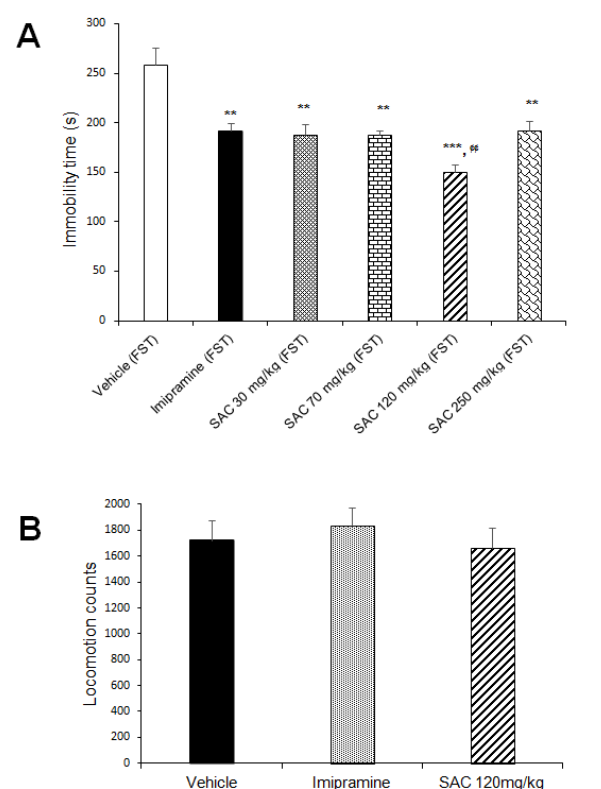
Figure 2. SAC produced an antidepressant-like response in the FST ( A ) and did not alter locomotor activity ( B ). Before FST, vehicle, imipramine (15 mg / kg), or SAC (30, 70, 120, or 250 mg / kg) were administered to mice daily for 17 days. Immobility time (in seconds) and locomotion scores are expressed as mean ± SEM, with 9–15 mice per group for antidepressant-like response and 11–15 mice per group for locomotor activity. The one-way ANOVA followed by post hoc Duncan’s test was used to analyze di ff erences among groups. (**) Statistically di ff erent from the vehicle-FST group (control group, p < 0.01, Duncan´s test; (***) Statistically di ff erent from the vehicle-FST group (control group), p < 0.001, Duncan´s test; ( ¢¢ ) statistically di ff erent from imipramine (FST) group, p < 0.01, Duncan´s test. FST = forced swimming test; SAC = S-allyl cysteine.